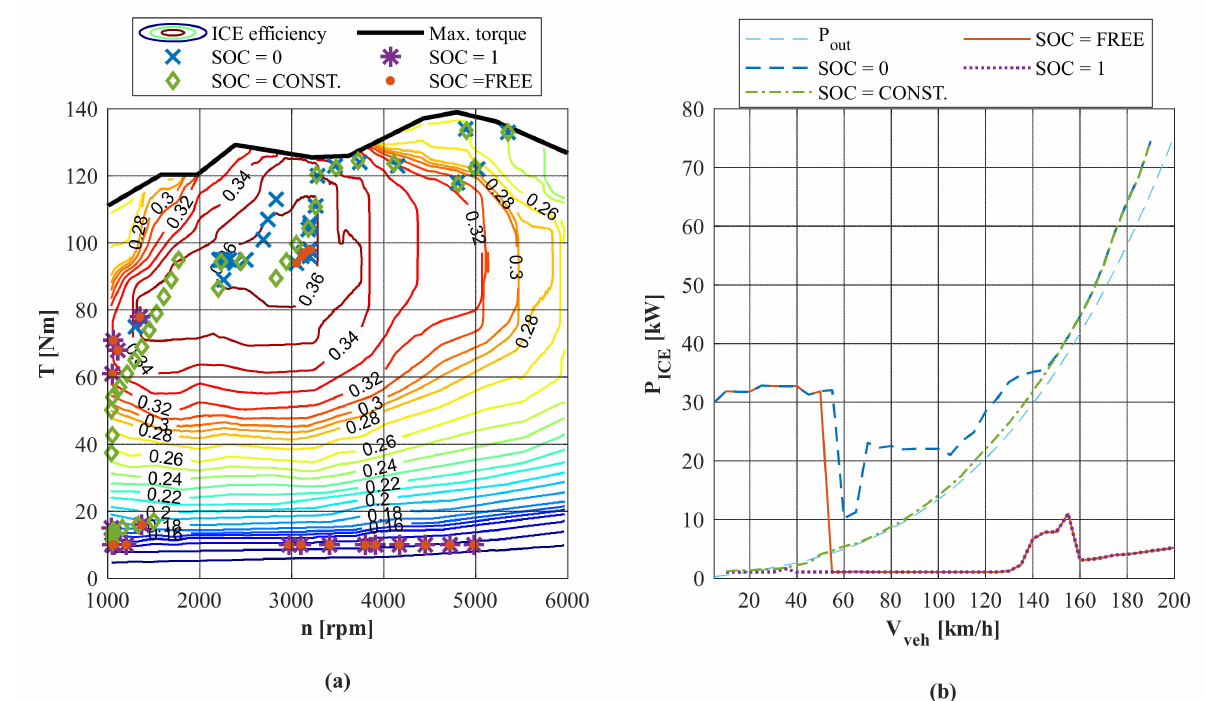
Figure 7. ICE optimal power-split operation: ( a ) ICE functioning points; ( b ) ICE power.